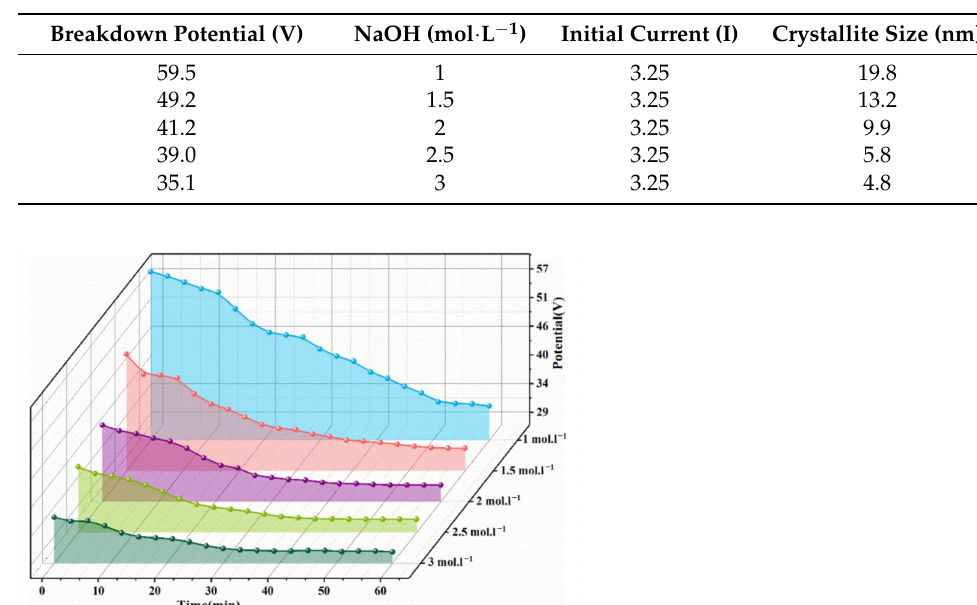
Figure 4. Relationship between breakdown potential, grain size, and NaOH concentration. Table 1. Effects of different NaOH concentrations on breakdown potential and the grain size of the synthetic powder.